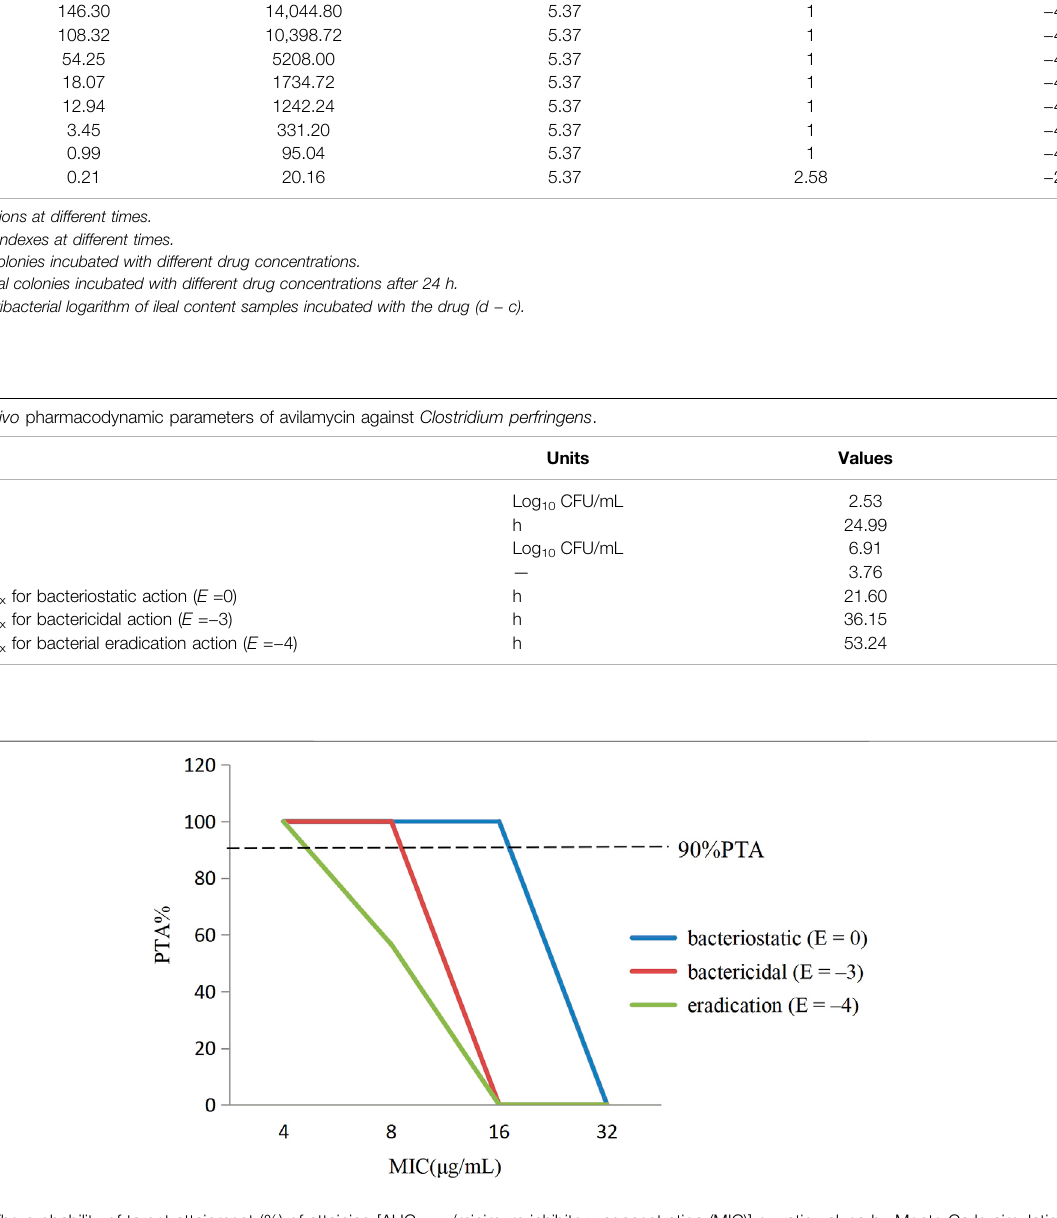
FIGURE 4 | The probability of target attainment (%) of attaining [AUC 0 – 24h /minimum inhibitory concentration (MIC)] ex ratio values by Monte Carlo simulation.